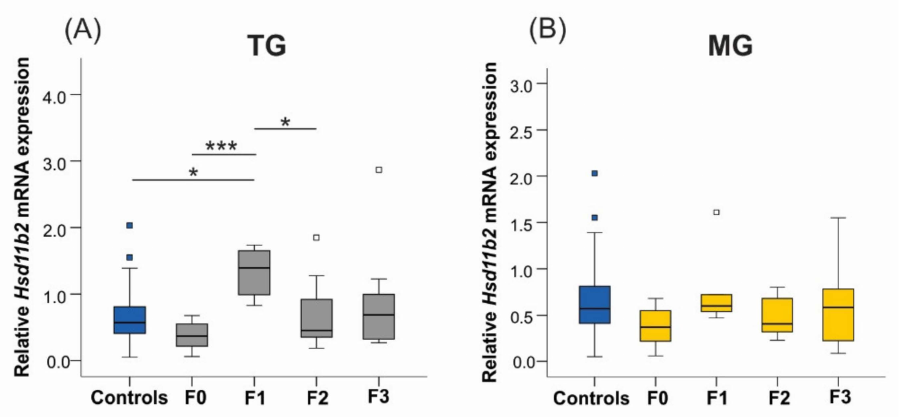
Figure 9. The uterine expression of Hsd11b2 significantly increased in the F1 generation of the TG lineage. ( A ) The abundance of Hsd11b2 tripled in the daughters’ uteri. ( B ) Expression levels of Hsd11b2 were unaltered when exposed to MG SIS. Asterisks indicate significance: * p < 0.05; *** p < 0.001. Controls n = 20–31; F0 n = 8–10; F1 n = 5–8, F2 + F3 n = 4–12. Box plots mid-lines indicate medians, whiskers indicate min-max values, and boxes indicate interquartile ranges.